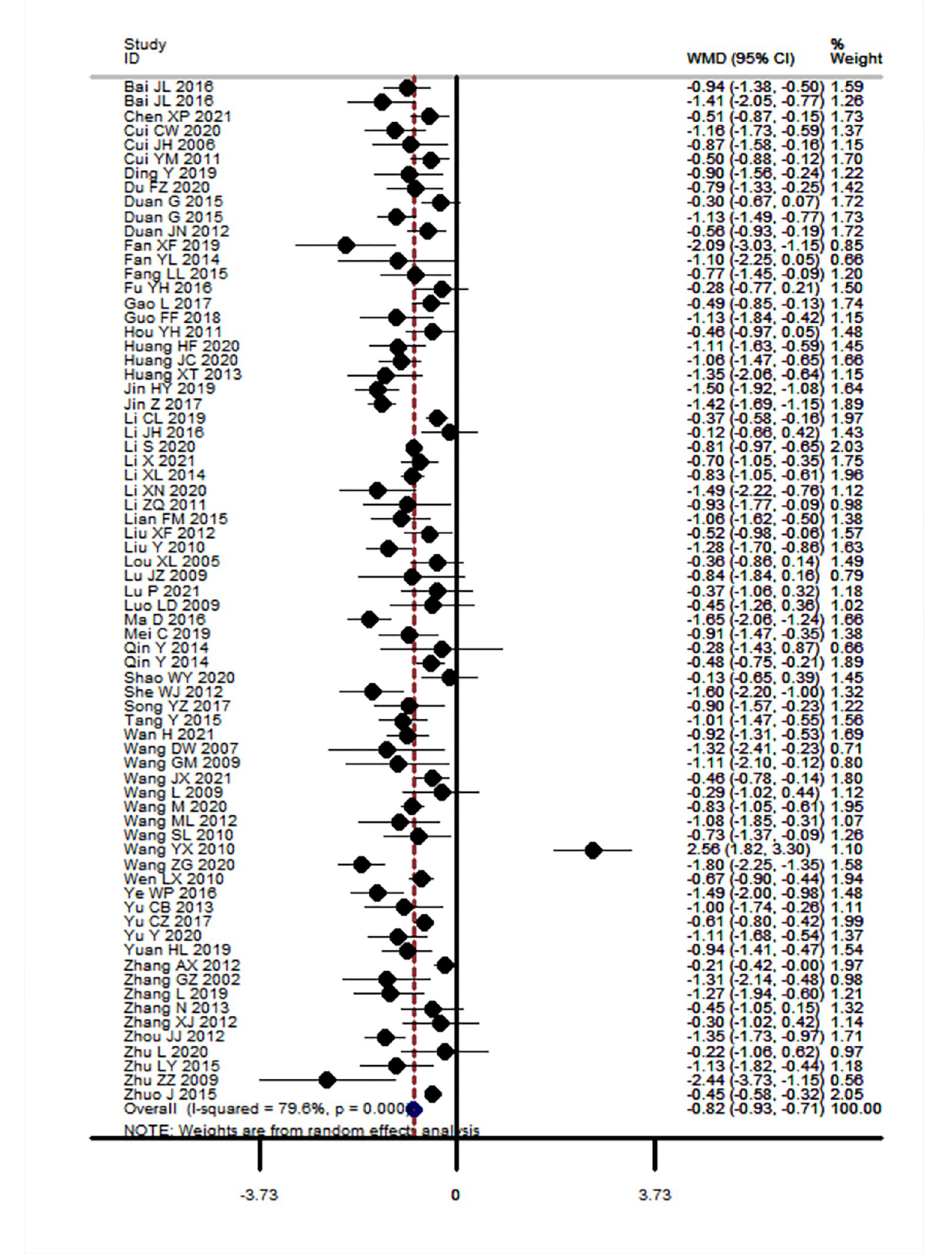
Fig 2. Forest plot of fasting blood glucose level at end of treatment, Fuling formulae plus hypoglycaemic agents versus hypoglycaemic agents alone, results of meta-analysis.